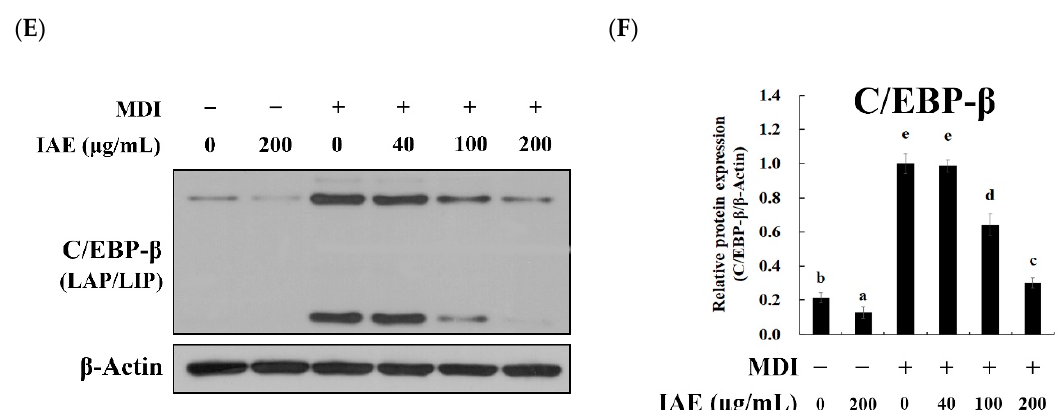
Figure 5. Inula britannica flower aqueous extract (IAE) inhibits the activation of STAT3 and C/EBP- β during the early phase of adipogenesis. Fully confluent 3T3-L1 preadipocytes were differentiated by MDI stimulation upon treatment with indicated concentrations of IAE. The phosphorylation of STAT3 (Tyr705) was examined to evaluate STAT3 activation. The expression levels of proteins were assessed with western blotting. ( A ) The time-course of MDI-induced STAT3 phosphorylation in the presence or absence of IAE. ( B ) The dose-dependent inhibitory effect of IAE on STAT3 activation was determined after 18 h of MDI stimulation. ( C ) Relative protein expressions of phosphorylated STAT3. ( D ) The time-course of MDI-induced C/EBP- β expression in the presence or absence of IAE. ( E ) The dose-dependent inhibitory effect of IAE on C/EBP- β was assessed after 4 h of MDI stimulation. ( F ) Relative protein expression levels of C/EBP- β . The data are presented as mean ± standard deviation. Values labeled with di ff erent letters (a–e) are significantly different ( p < 0.05). Differences among the multiple groups were determined based on one-tailed one-way analysis of variance, followed by Tukey’s post hoc test.